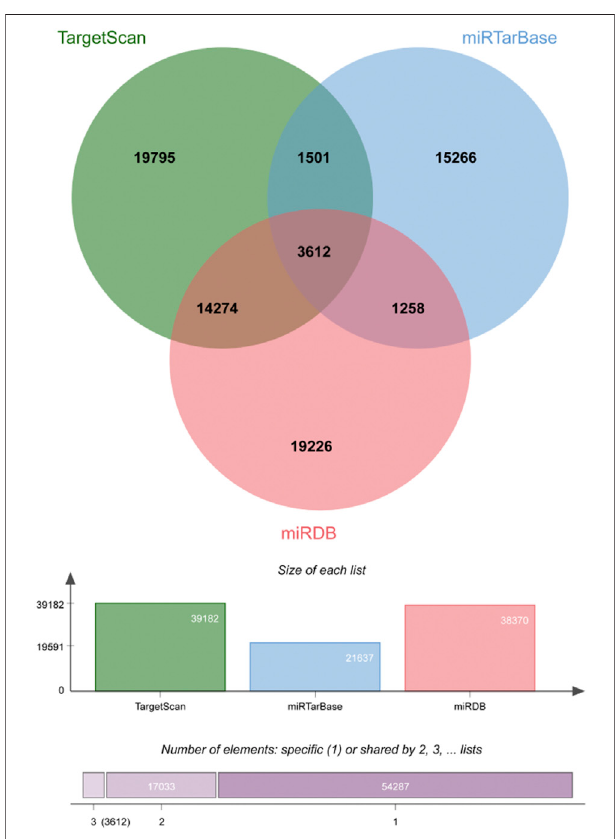
FIGURE 5 | Veen plot of mRNAs predicted by